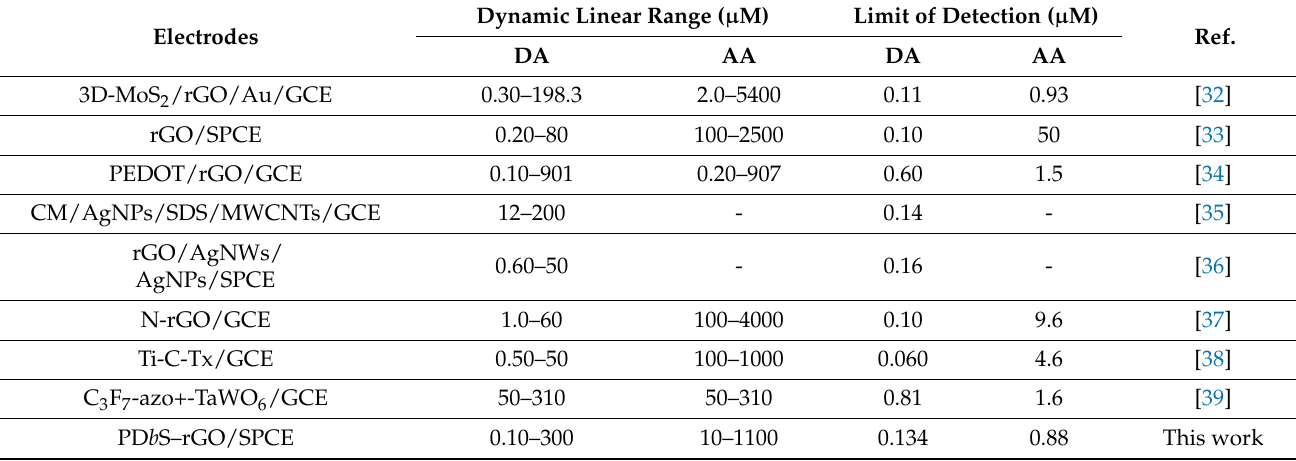
Table 1. Performance comparison of proposed sensor with other reported sensors for simultaneous detection of DA and AA.